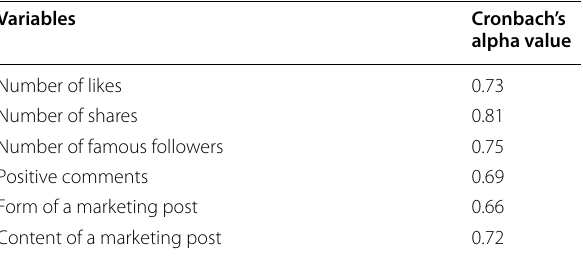
Table 1 Reliability by internal consistency